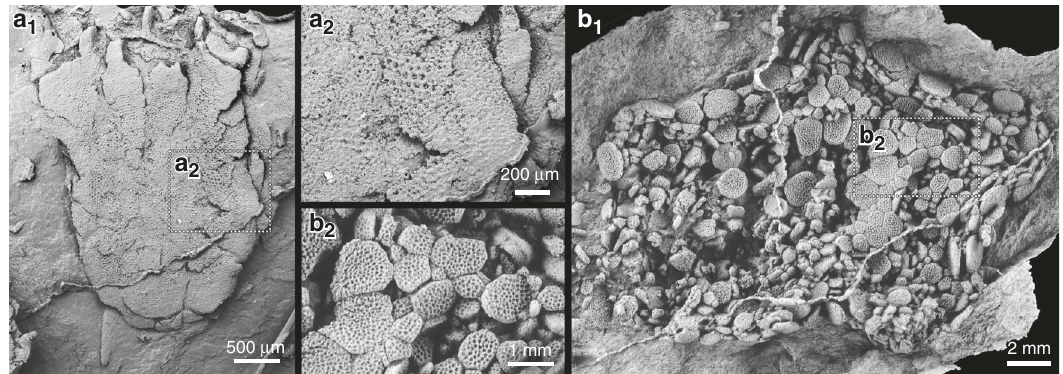
Fig. 1 Latex casts of Cambrian echinoderms from the Jbel Wawrmast Formation (Morocco) showing relic “ ghost ” stereom microstructure associated with the presence of originally calcitic plates. a SEM image of a ctenocystoid with a loosely calci fi ed ventral surface. Specimen NHMUK EE15317 ( a 1 ). General view ( a 2 ). Detail showing stereom in the surface of the plates. b Ventral surface of an edrioasteroid. Photograph of latex cast whitened with ammonium chloride sublimate. Specimen NHMUK EE15308 ( b 1 ). General view.( b 2 ). Detail of plate sutures and ornamentation. Specimens housed in the Natural History Museum, London